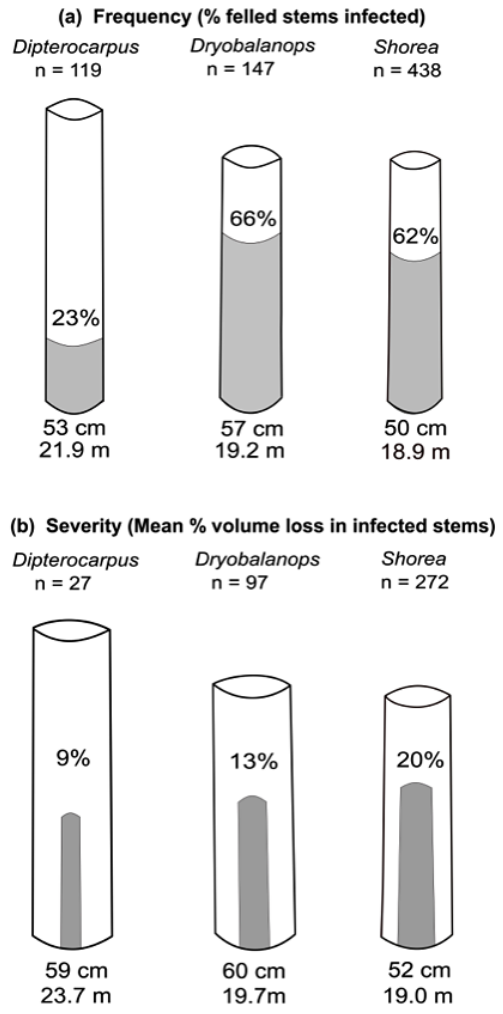
Figure 3. Variation in the frequency and severity of stem rot among three important dipterocarp genera (representing a subset of the 65 genera from the felling data) in the rain forest of Central Sarawak, Borneo, Malaysia. The number of trees ( n ) sampled for each genus is listed. For each genus, Dipterocarpus , Dryobalanops , and Shorea , 17, 4, and 61 species were sampled, respectively. Mean diameter at breast height (DBH;cm) is on the first row beneath each cylinder, and mean stem length (m) is below that, with cylinders sized according to mean diameter and stem length. The shaded por- tions represent in (a) the frequency of stem rot (the percent of felled trees with stem rot) and in (b) the severity of stem rot (the mean percent volume lost to stem rot), with actual percentages above the shading.